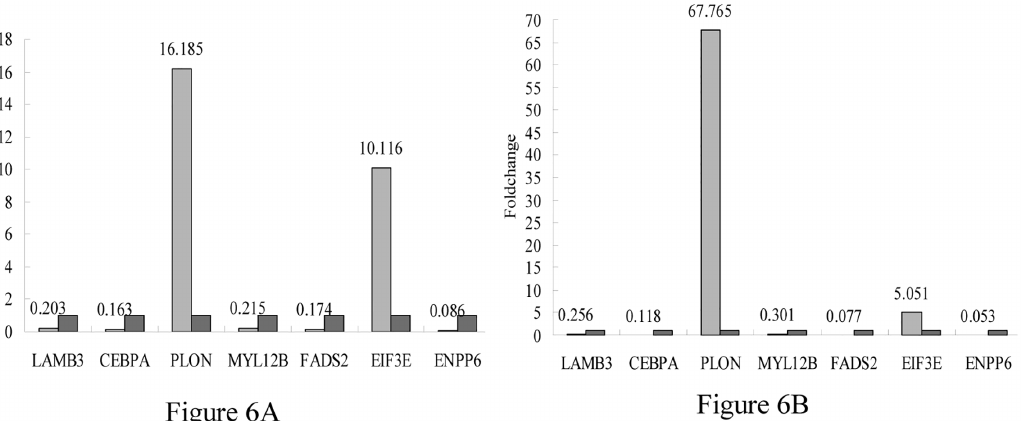
Fig 6. Analysis of the differentially expressed genes during skin growth and development in rabbits. (A), real time PCR validation of differentially expressed genes in plaice and un-plaice rabbit skin samples. (B), gene expression levels in plaice and un-plaice rabbit skin samples expressed as fold change. The red columns represent the control gene used for normalization (fold change set at